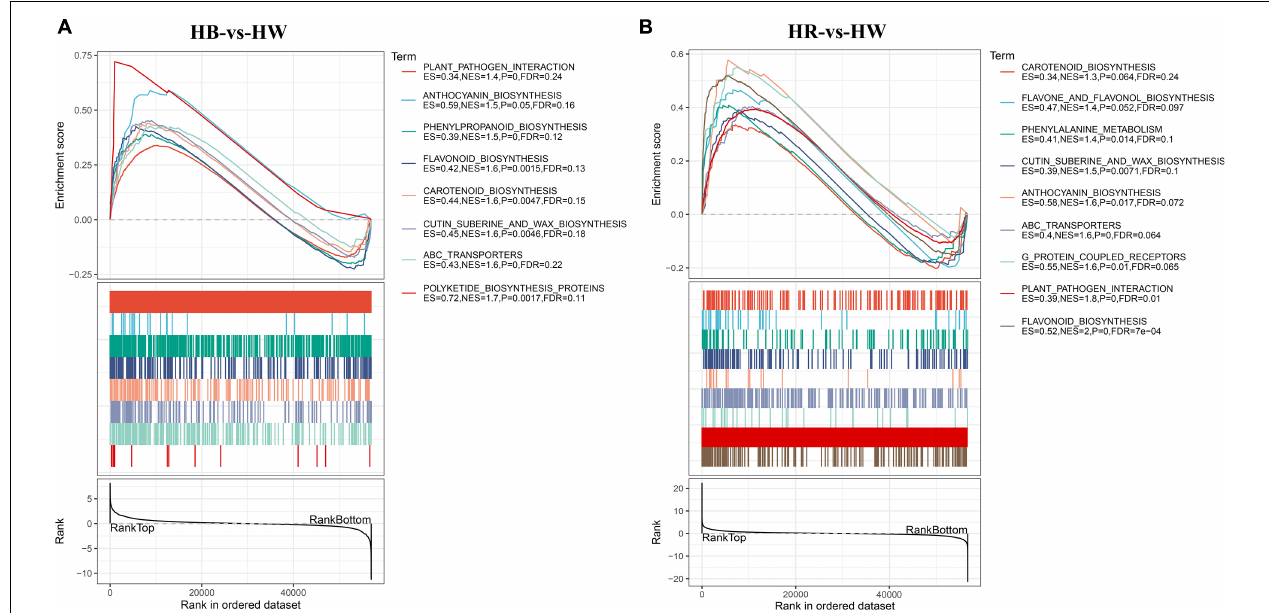
FIGURE 5 | Gene set enrichment analysis (GSEA). GSEA was performed in the HB-vs-HW (A) and HB-vs-HW (B) groups. Gene sets with a normalized enrichment score (NES) > 1 and FDR < 0.25 were considered as statistically significant. HW, HR, and HB indicates samples treated by white light, red light, and blue light,